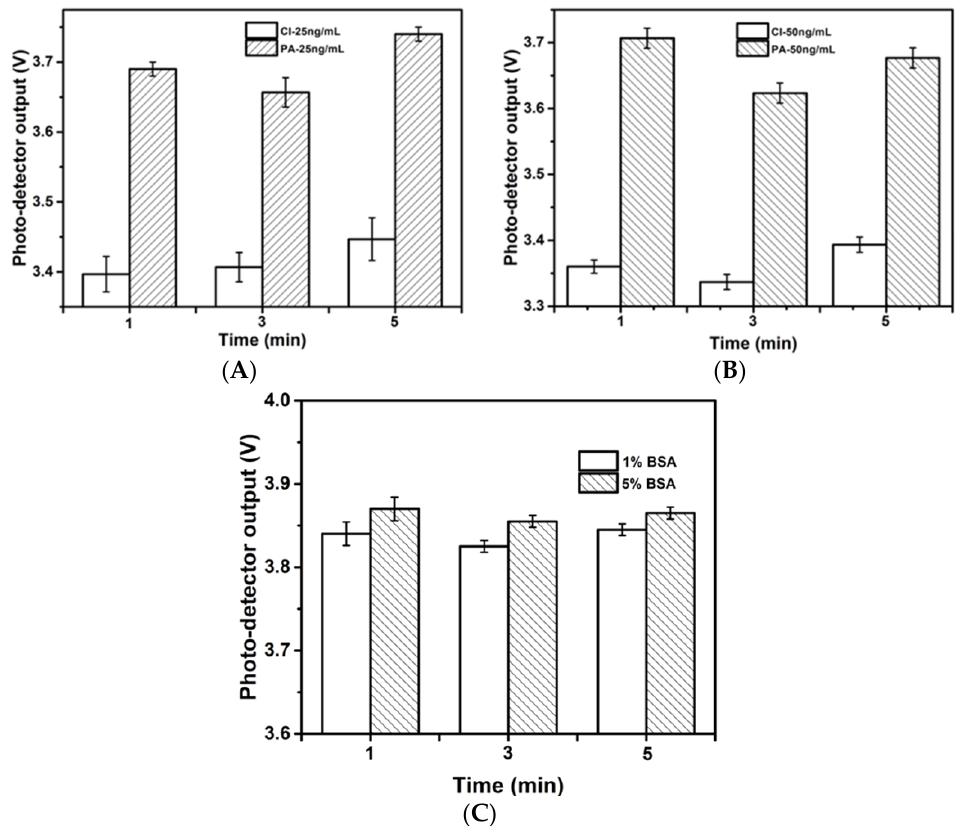
Figure 2. Photo-detector biosensor output of optical absorption detection upon gluten standard solution of 25 ng/mL ( A ) and 50 ng/mL; ( B ) by two different antibody immobilization strategies, passive adsorption (PA) and covalent immobilization (CI). Optimization of the blocking step by using blocking buffer of 1% (w/v) and 5% (w/v) BSA in PBS for gluten standard solution of 50 ng/mL; ( C ) Experiments were conducted without coating antibodies on the microchannels. The higher concentration of the blocking buffer improved the blocking efficiency.